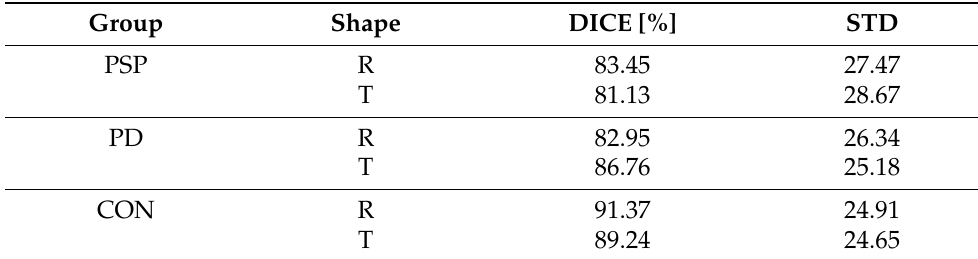
Table 1. Results of the shape recognition